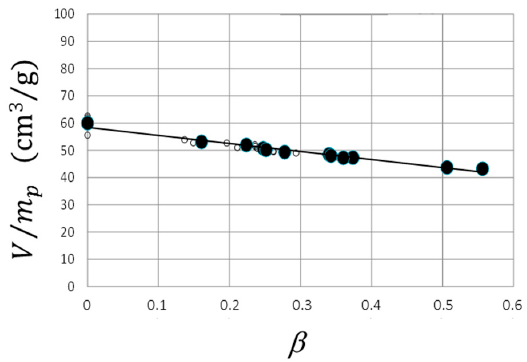
Figure 6. V / m p vs. β for PSS macrogels in lysozyme solution, pH = 8.0, I = 10 mM. The line is a linear fit to the data, V / m p = − 31.6 β + 59 (cm 3